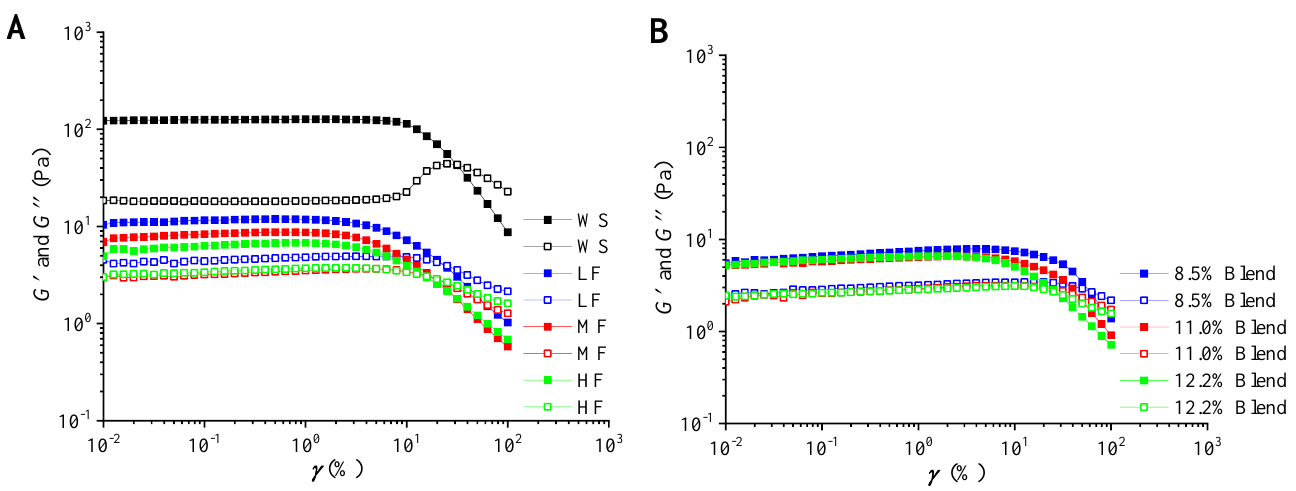
Figure 3. Storage modulus ( G′ , solid) and loss modulus ( G″ , hollow) as a function of strain of the film-forming matrices at a frequency of 1 Hz at 25 °C: ( A ) pure WS, wheat flours with different protein contents (8.5%, 11.0%, and 12.2%), and ( B ) WS – gluten blends with different protein contents (8.5%, 11.0%, and 12.2%).